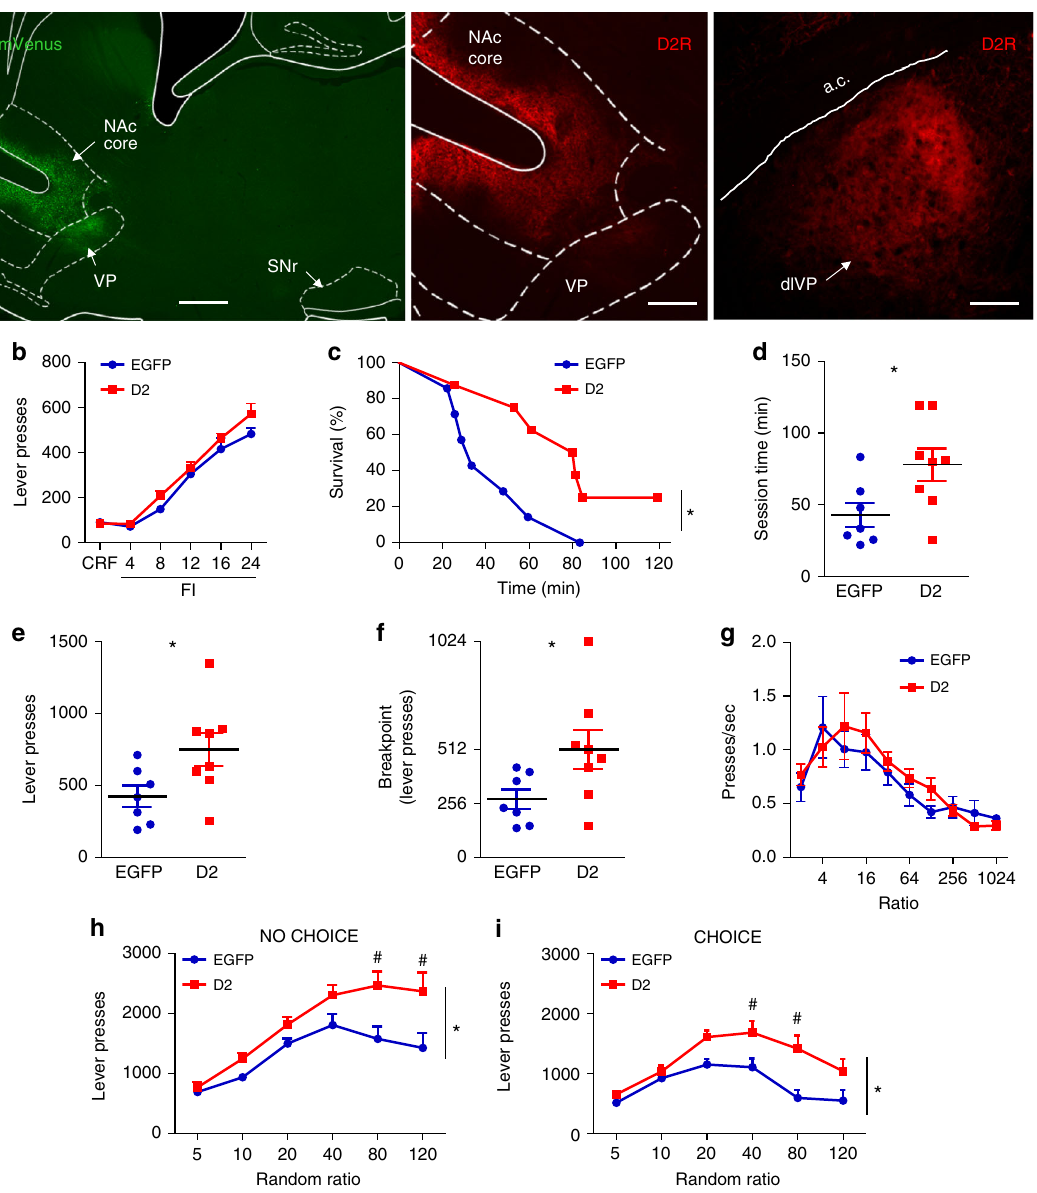
Fig. 1 D2R upregulation enhances motivated behavior. a (Left) Sagittal image of a Drd2-Cre mouse showing that virus-mediated expression (mVenus) is largely restricted to neurons in the NAc core. mVenus-positive terminal fi elds are observed in the VP, but not the SNr. Scale = 500 µ m. (Middle) Higher magni fi cation image shows increased D2R immunolabeling in the NAc core and in the VP. Scale = 250 µ m. (Right) Coronal view of viral D2R-positive terminal fi elds in the dorsolateral VP (dlVP). Scale = 150 µ m. b D2R overexpression did not alter operant learning on continuous reinforcement